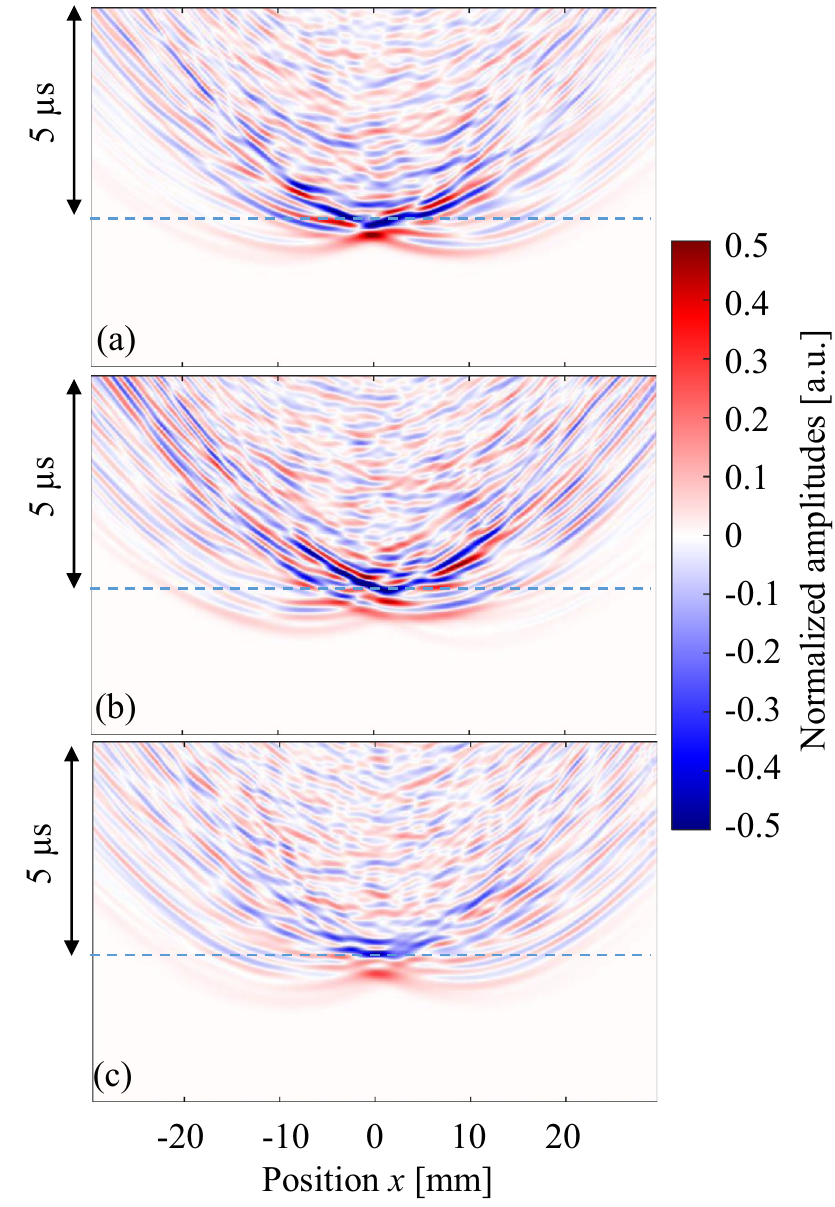
Figure 6. Observed waves at different positions. Ultrasonic waves propagated through ( a ) sample A, ( b ) sample B and ( c ) sample C. BV/TV values of these samples were 55–56%. Dashed lines indicate the arrival time of the wave which passed through water